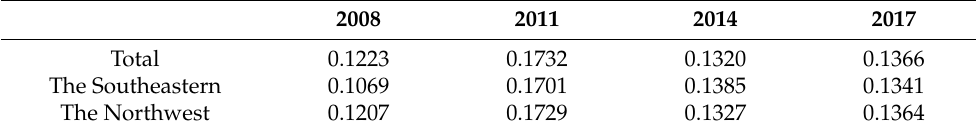
Table 2. Functional coordination of “production-living-ecology” in China from 2008 to